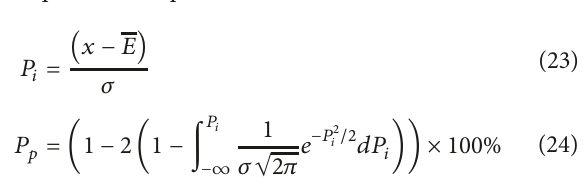
calculate the 𝑄(𝑠, 𝑎) according to